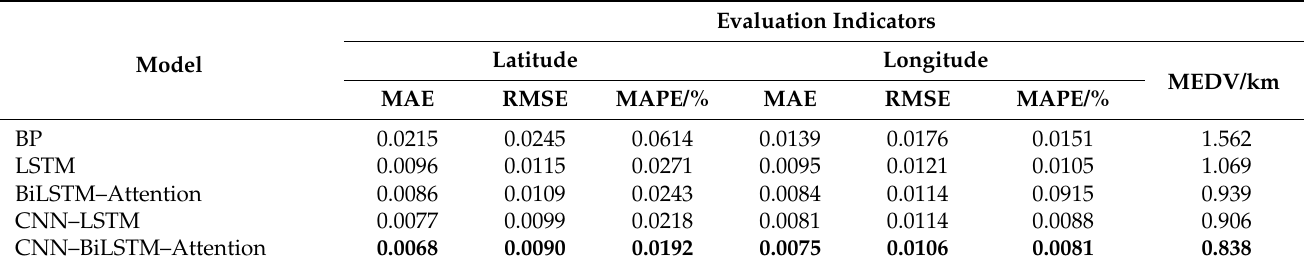
Table 3. Comparison of four models in evaluation